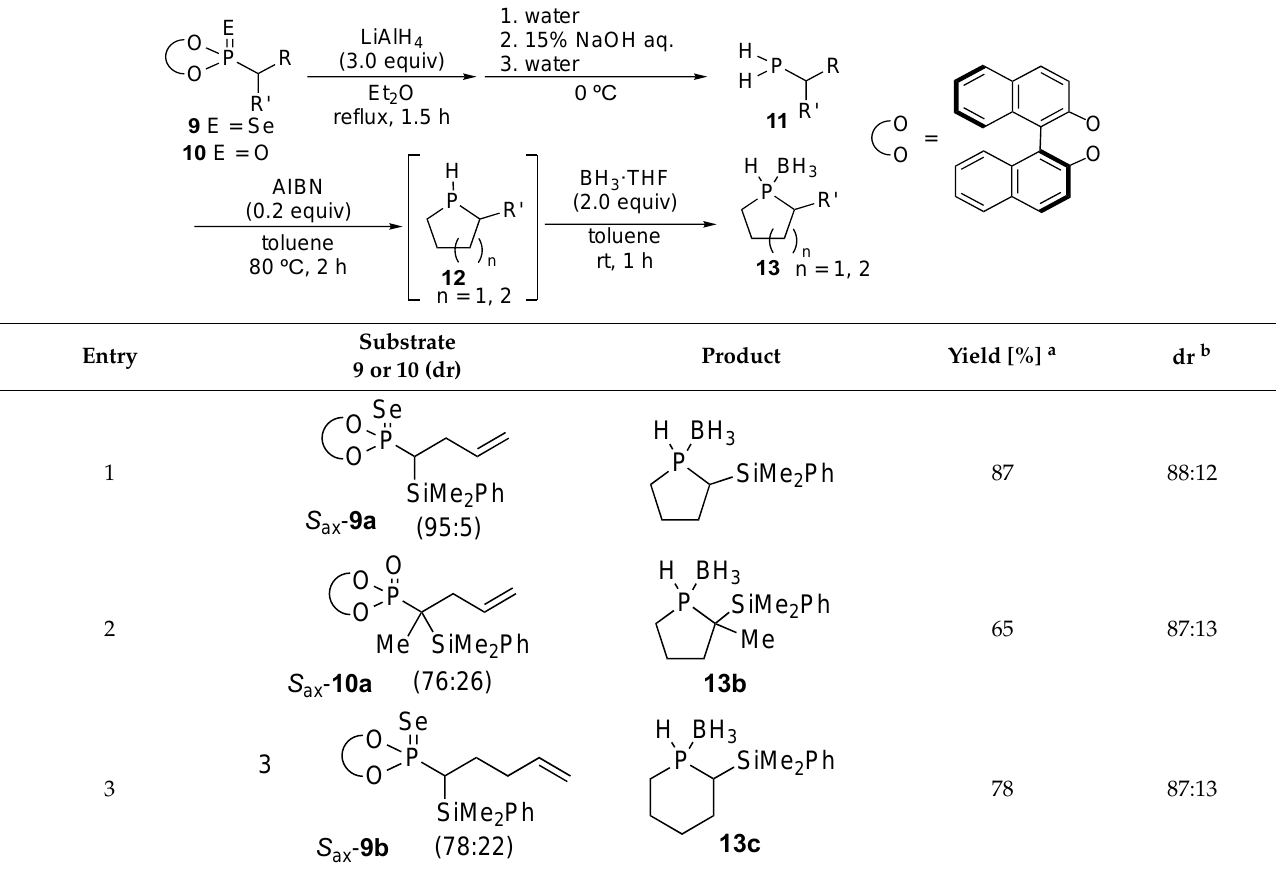
Table 3. Intramolecular cyclization reaction of primary phosphines generated from phosphonoselenoates 9 and phosphonates 10 .